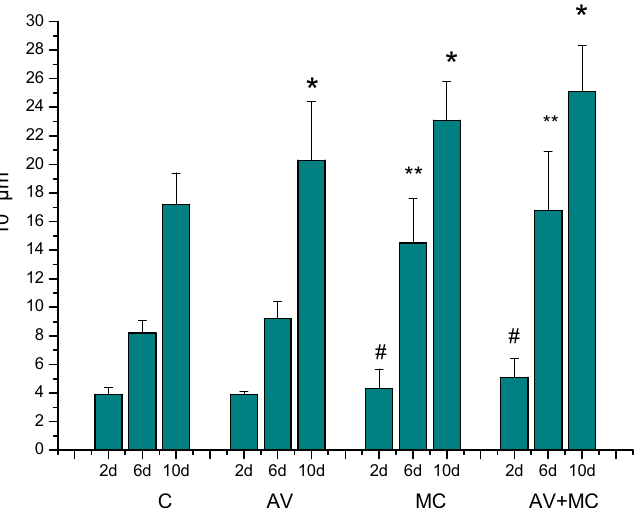
FIGURE 3 – Measurement of healing area in the region of the skin wound experimentally induced in normal 120-day-old Wistar rats after 2, 6 and 10 days of treatment. C: control; AV: animals topically treated with Aloe vera ; MC: animals treated with microcurrent (10 µA/2 min); AV+MC: animals receiving topical application of Aloe vera plus microcurrent (10 µA/2 min). Values are reported as means ±SD. #, ** and * represent p<0,05.